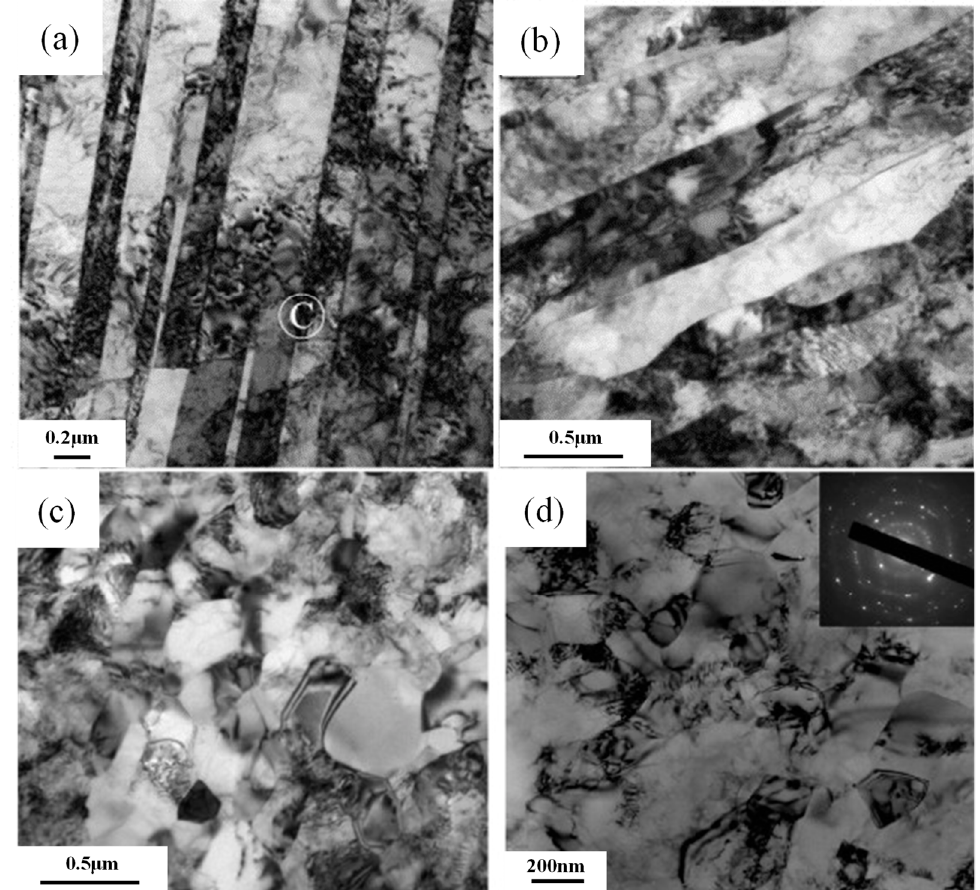
Figure 8. Microstructure of pure titanium under different passes [55]: ( a ) one pass; ( b ) two passes; ( c ) four passes; ( d ) eight passes. Reproduced with permission from Elsevier B.V.